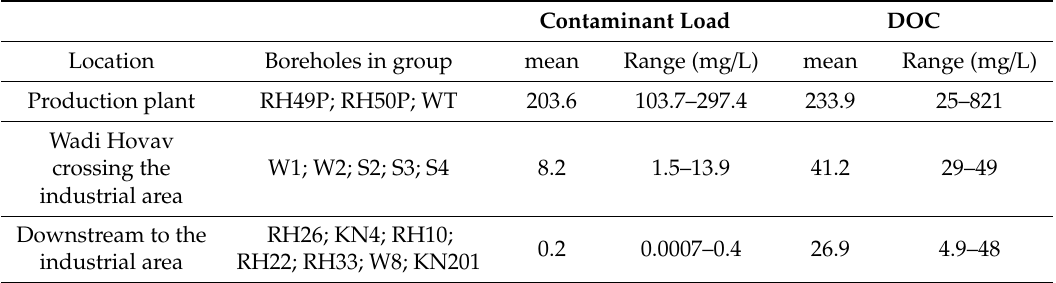
Table 3. Mean contaminant load and dissolved organic carbon (DOC) of the three locations based on the ordination results. contaminant load-taken from the Neot Hovav annual sampling report for year 2014 [36]; DOC-2015